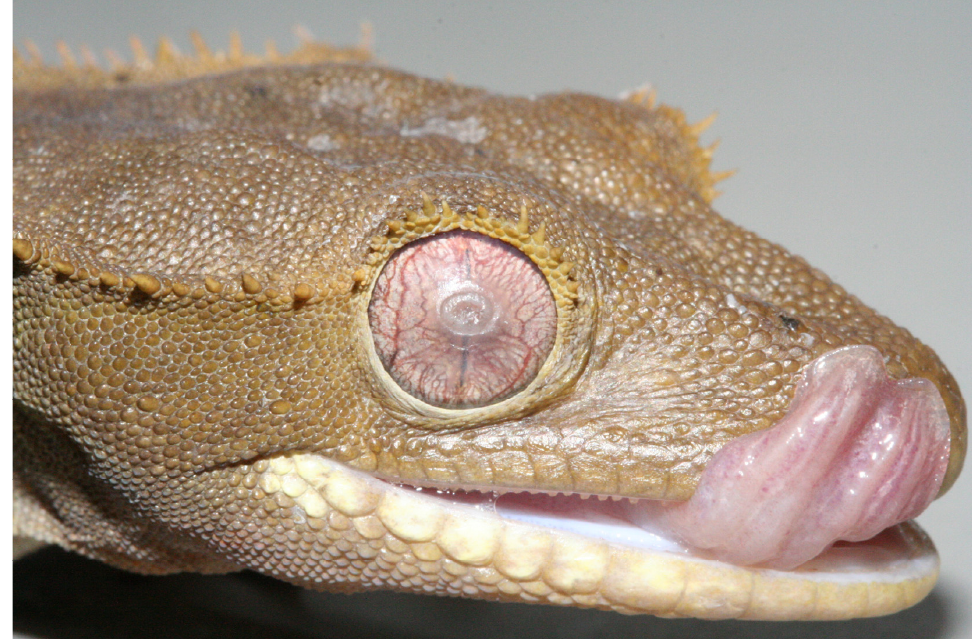
Figure 19. Ulcerative lesion located at the center of the spectacle in a crested gecko ( Correlophus ciliatus ).